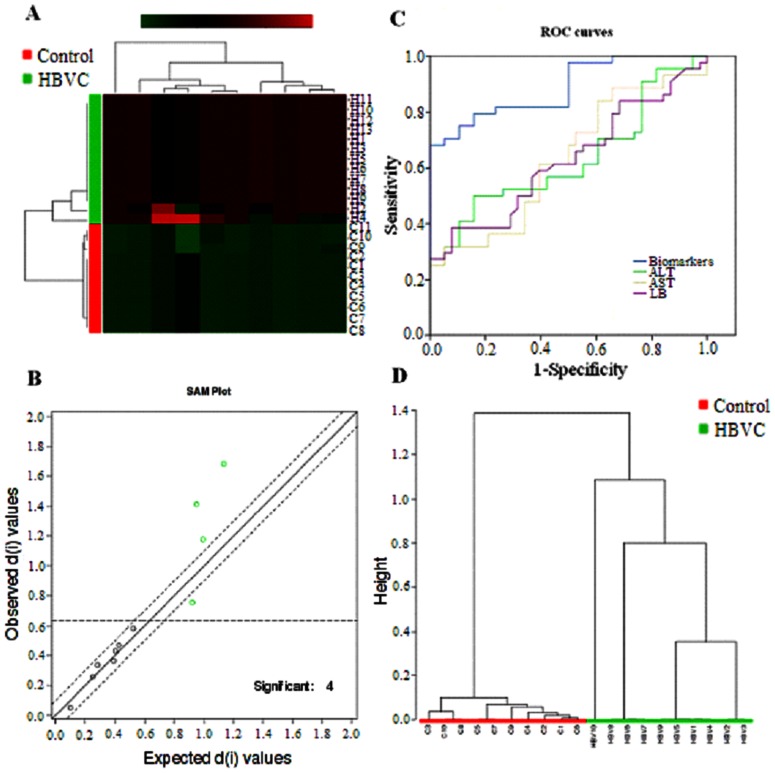
Heatmap visualization and hierarchical clustering analysis with MetaboAnalyst's data annotation tools constructed based on the differential metabolites of importance for the urine of HBV (A).Rows: samples; Columns: metabolites; Color key indicates metabolite expression value, blue: Lowest, red: highest. The significance analysis for microarrays method used to select 4 marker metabolites (B). ROC curves for the diagnosis between controls and HBV patients using data from conventional clinical chemistry markers and the metabolic markers (C). The unsupervised clustering dendrogram of prediction and diagnostic potential of the marker metabolites, tested our approach using a second set of HBV (n = 10) patients and control subjects (n = 10) to be blindly selected (D).